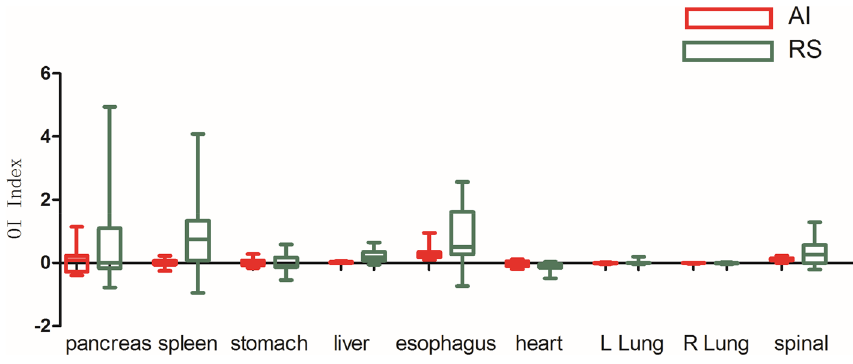
Figure 8. Comparison results of D v between two software in automatic delineation of lung cancer